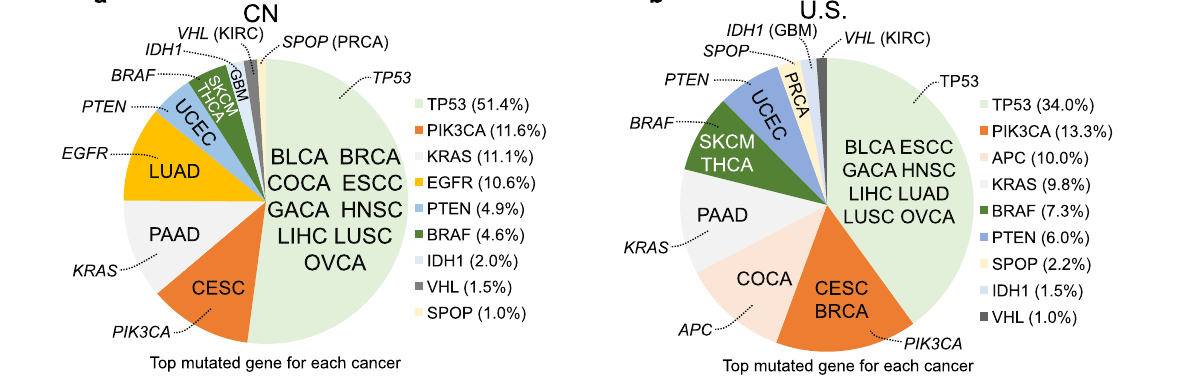
carcinoma (ESCC), High-grade serous ovarian carcinoma (OVCA), Lung squamous cell carcinoma (LUSC), Head and neck squamous cell carcinoma (HNSC), Gastric adenocarcinoma (GACA), Bladder urothelial cancer (BLCA), Liver hepatocellular carcinoma (LIHC), Colorectal adenocarcinoma (COCA), Lung adenocarcinoma (LUAD), Breast cancer (BRCA), Pancreatic adenocarcinoma (PAAD), Brain glio- blastoma/glioma (GBM), Papillary thyroid carcinoma (PTC), Skin cutaneous mela- noma (SKCM), Kidney renal clear cell carcinoma (KIRC), Uterine corpus endometrialcarcinoma(UCEC),Cervicalsquamouscellcarcinoma(CESC),Prostate adenocarcinoma (PRCA). Source data are provided as a Source Data